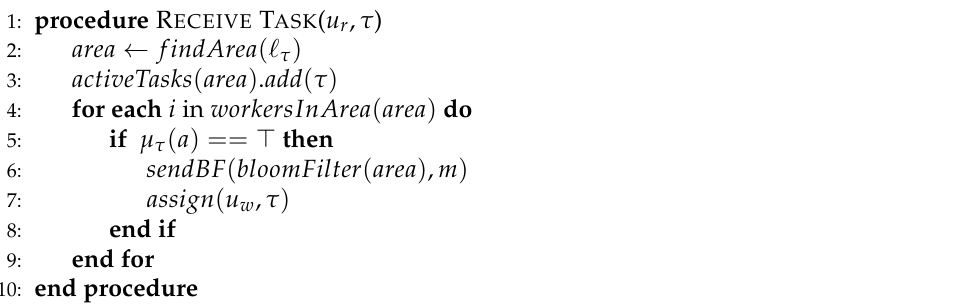
Algorithm 4 Arrival of a new result in the area covered by the ME host